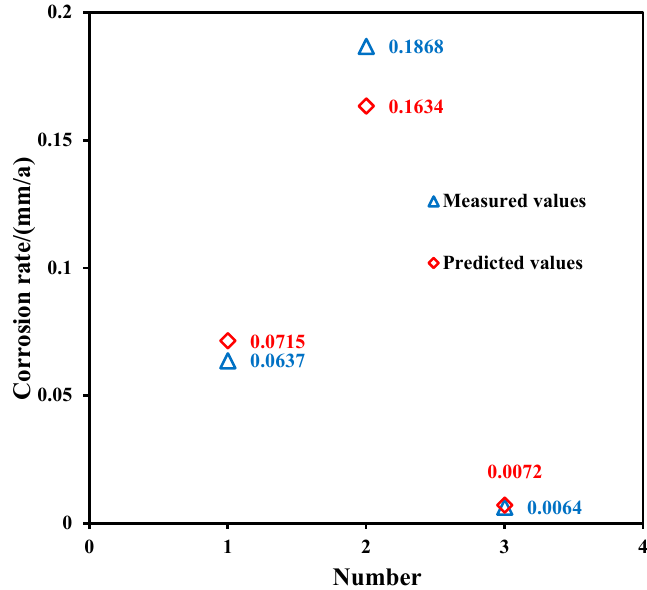
7 of 12 Figure 2. The curve of corrosion rate and corrosion factors with pipeline mileage. Table 3. The relative error between predicted and actual value.